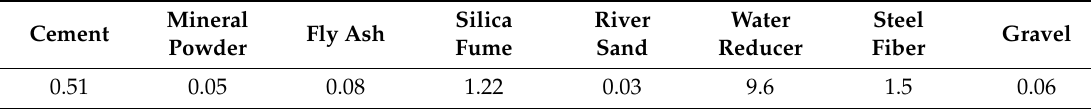
Table 14. Test material price information.